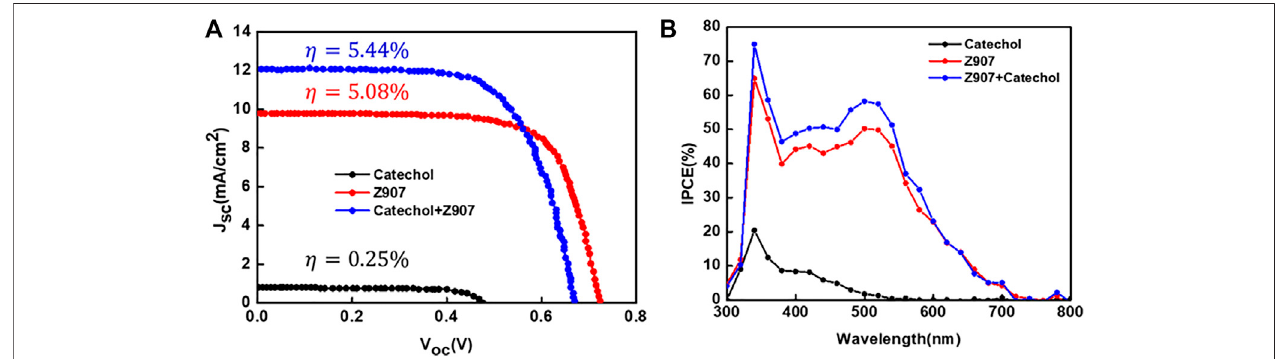
FIGURE 4 | (A) Current – voltage plots and (B) IPCE spectra of representative devices fabricated with the sensitizers in organic solvent – based electrolyte under AM1.5G illumination